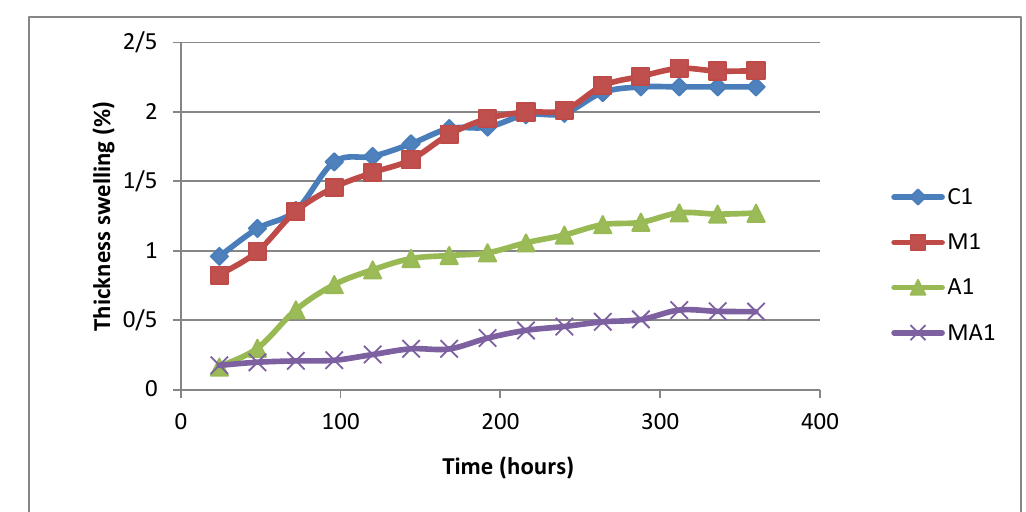
Fig. 8. Comparison of thickness swelling, among various treatments, due to moisture absorption for P1 fibre